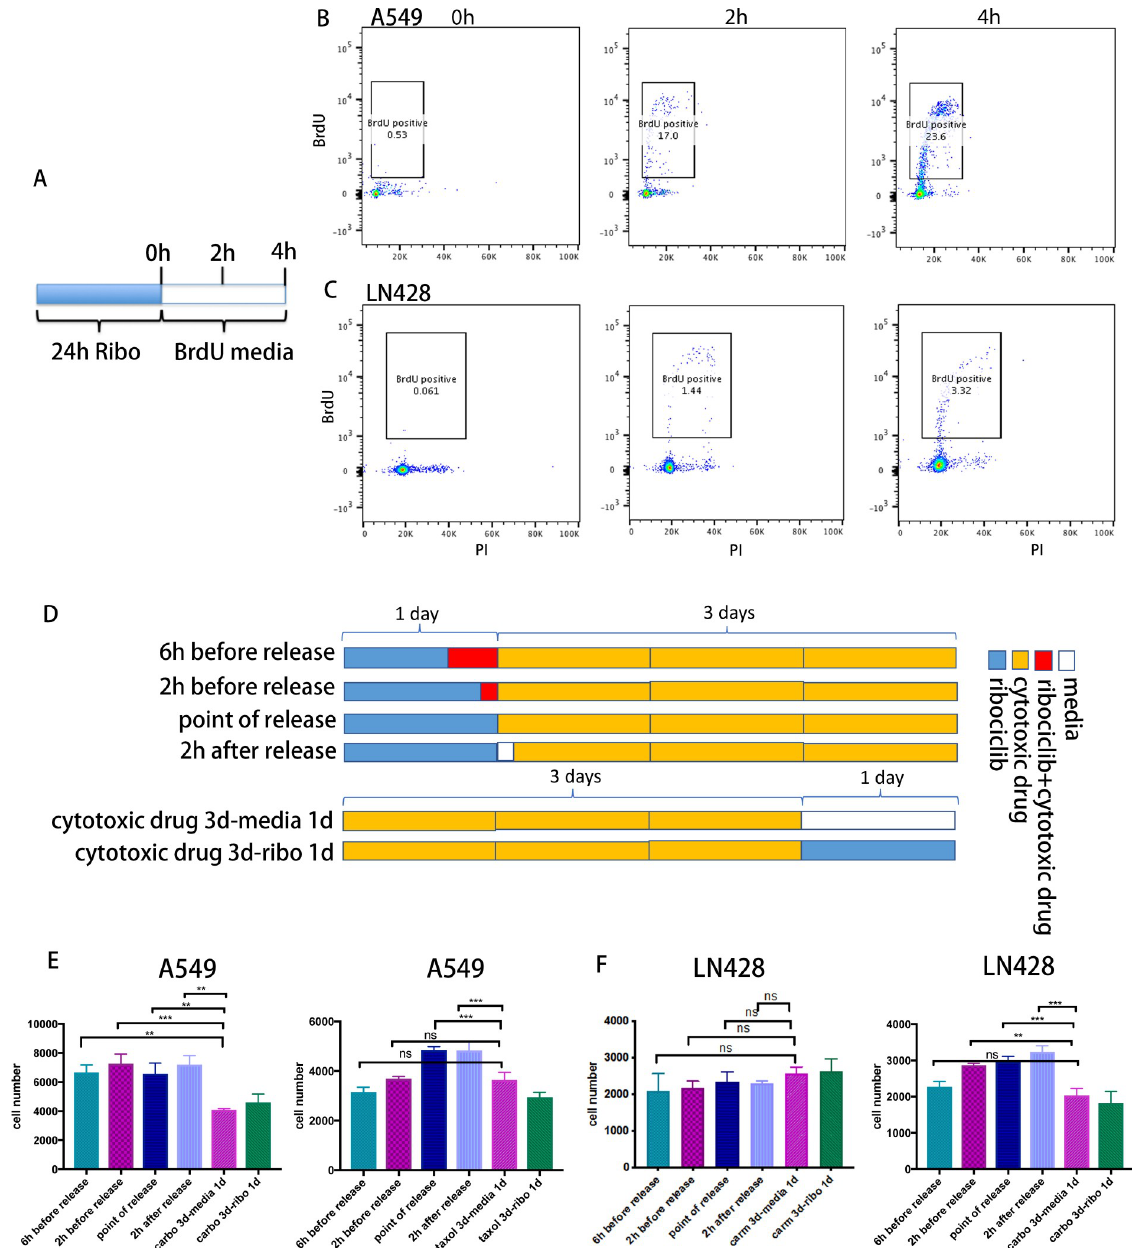
Fig 5. Precise coordination of S-phase entry after ribociclib withdrawal and exposure to cytotoxic drugs did not enhance cytotoxicity. (A) A diagram of the schedule for release from ribociclib-synchronized G1/S arrested cells.(B-C) Representative FACS plots of a BrdU incorporation assay in A549 (B) and LN428 (C) cell lines after release from ribociclib-synchronized G1/S arrest. (D) Diagrams of coordination schedule of S-phase entry (BrdU incorporation) and treatment with cytotoxic drugs.(E-F) Representative graphs of 3 independent repeats of a cytotoxicity assay based on the coordination schedule in D in A549 (E) and LN428 (F) cell lines. carbo: carboplatin; carm: carmustine. All values are numbers of live cells remaining in culture at the end of treatment and presented as mean (SD). P-value was calculated by one-way ANOVA: � , p < 0.033; �� , p < 0.02; ��� , p <